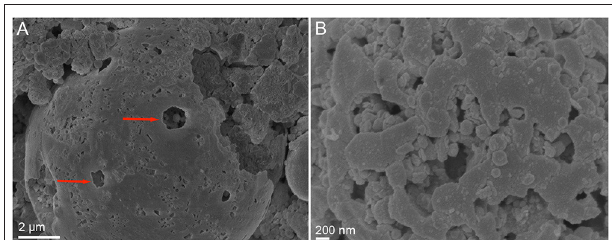
FIGURE 5 | SEM images showing the microbially etched surface of grains of waste material product bioprocessed by A. manzaensis . (A) The microbially etched pits are depicted by the red arrows. (B) Magnified SEM image of microbially etched surface.